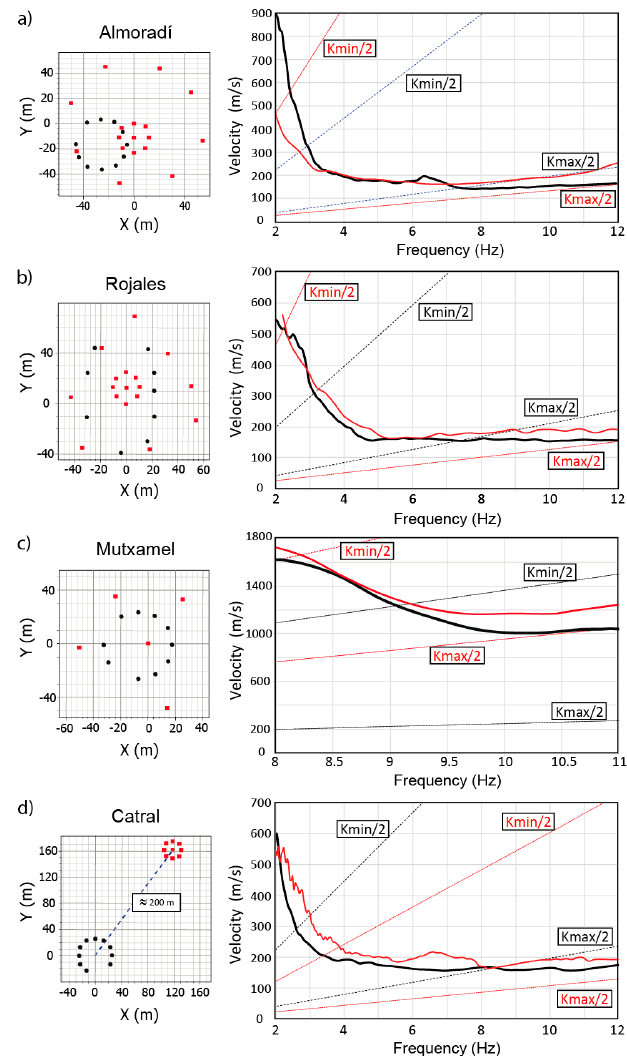
Figure 19. Array geometries (left column) and estimated dispersion curves (right column) for the Geophonino-W (black color) and the commercial equipment (red color) at the sites under study: ( a ) Almorad í ; ( b ) Rojales; ( c ) Mutxamel; and ( d ) Catral. Wavenumber limit functions for kmax / 2 and kmin / 2 values are represented with dashed lines in the corresponding